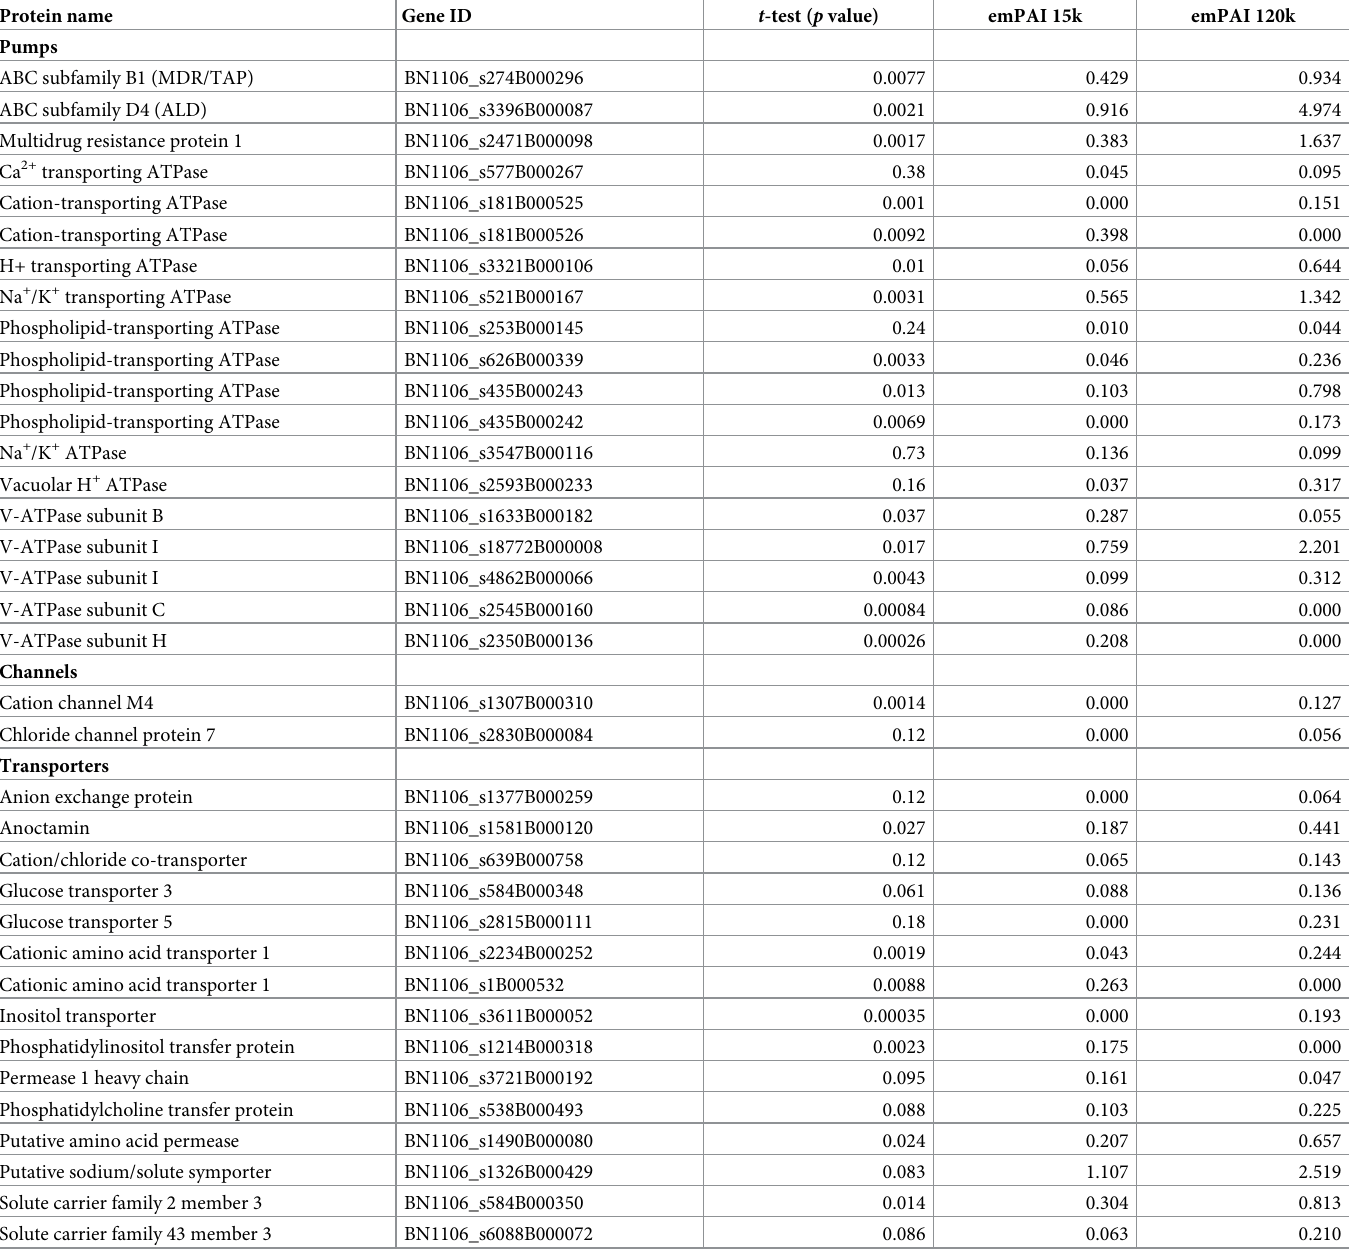
Table 1. Membrane transport proteins found on the surface of F . hepatica